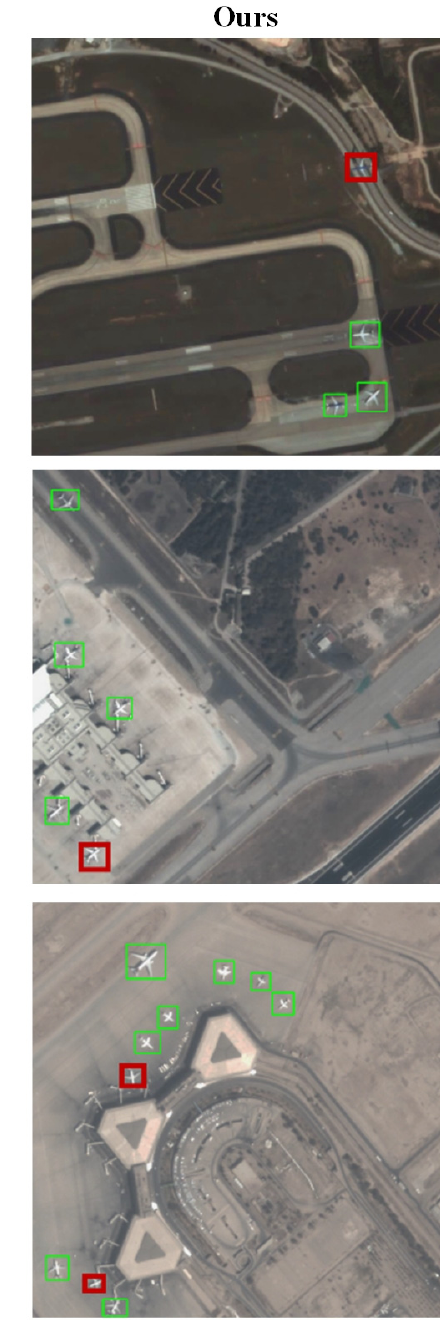
Figure 5. Visualization comparison between the proposed method and the baseline in ( a ) high-speed movement, ( b ) similar object interference, and ( c ) small size scenarios (green, blue, red, and yellow represent the results of the proposed method, the results of the baseline, missed detection, and false detection, respectively).